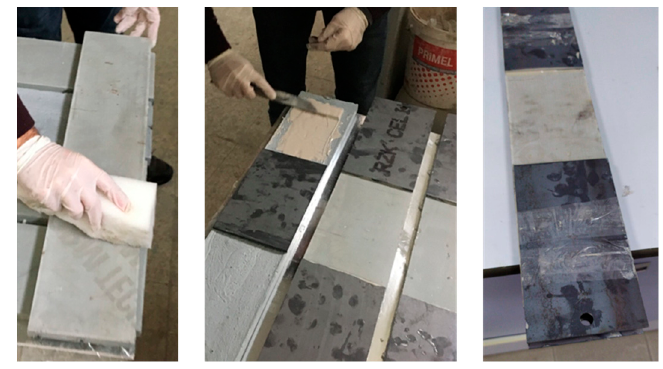
Figure 4. Bonding the steel apparatus to the sample for the tensile tests.